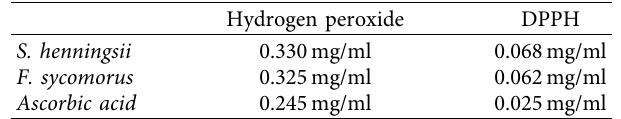
Table 6: IC 50 values of DCM extracts of S. henningsii and F. sycomorus .